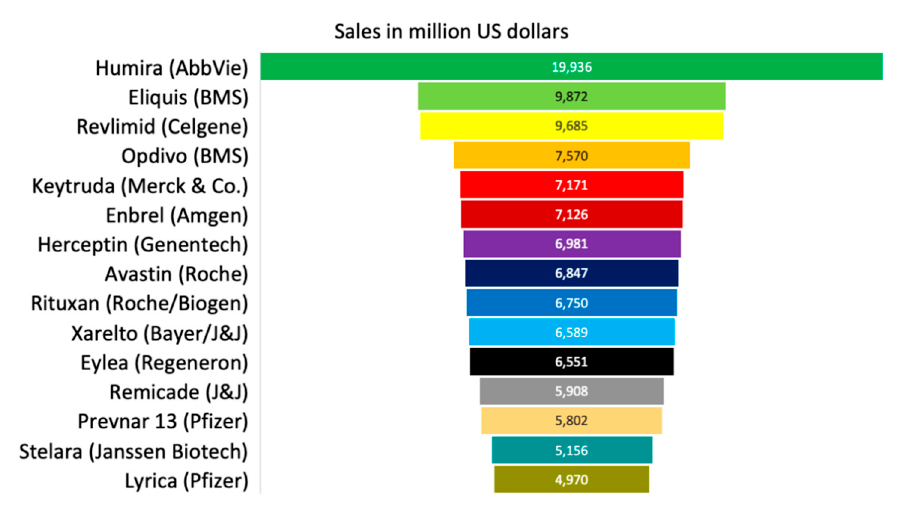
Int. J. Environ. Res. Public Health 2021 , 18 , x FOR PEER REVIEW Figure 4. Global revenue by pharmaceutical group [83]. Figure 4. Global revenue by pharmaceutical group [83].